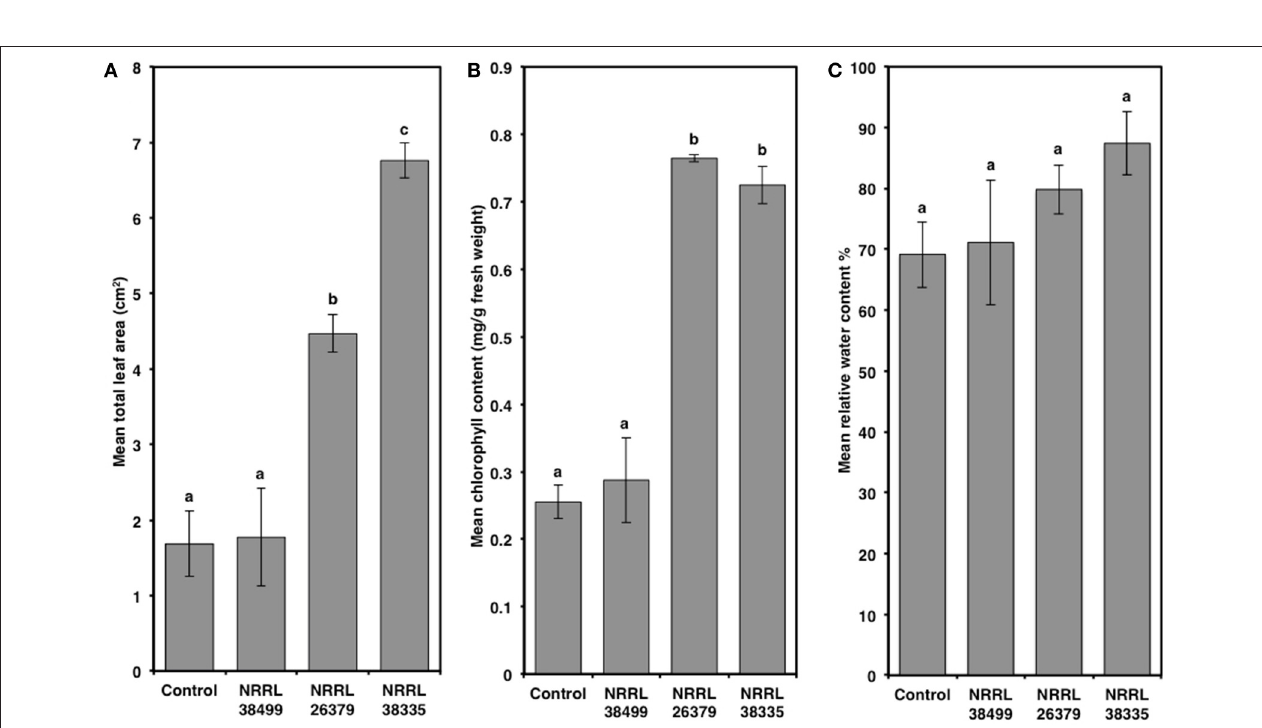
FIGURE 5 | Alterations of leaves caused by F. oxysporum volatiles. (A) total leaf area, (B) chlorophyll content, and (C) relative water content in Col-0 leaves after 2 weeks of cocultivation with no fungus (control), NRRL 38499, NRRL 26379, and NRRL 38335 are shown. Means and standard errors for four biological replicates per treatment, with five seedlings per replicate, are shown. Different letters on columns represent statistically significant differences by one-way analysis of variance. Scanned images of representative leaves used for (A) are shown in Supplementary Figure 5.